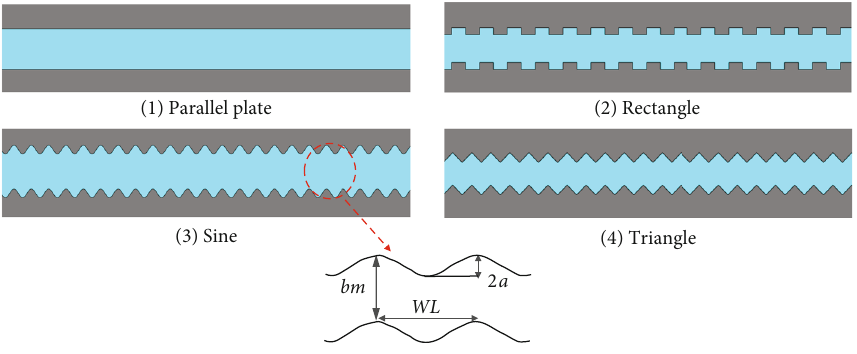
Figure 2: Rough fracture